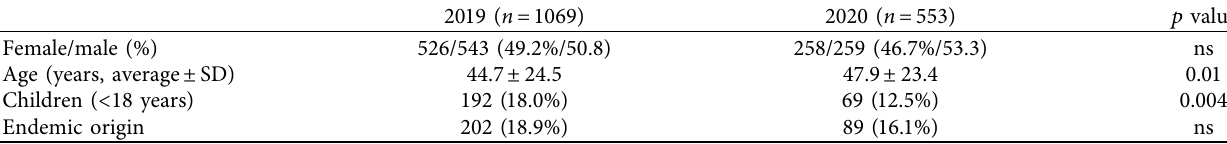
Table 1: The demographics of the study population in each year.